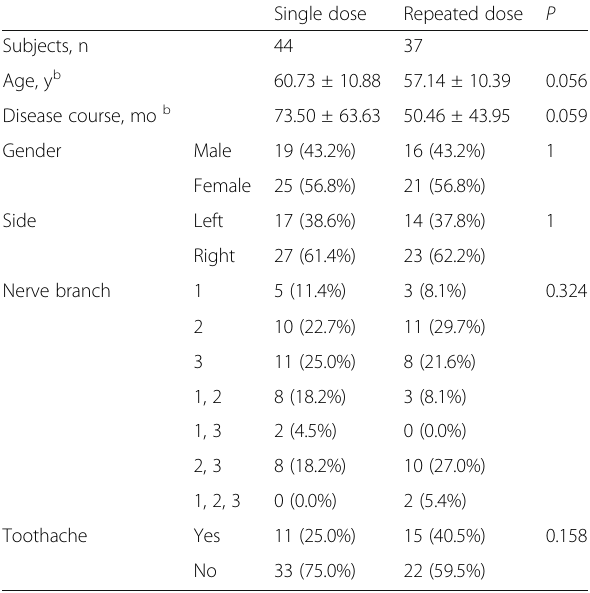
Table 1 Baseline demographic characteristics and clinical data of TN patients given single or repeated dose BTX-A a